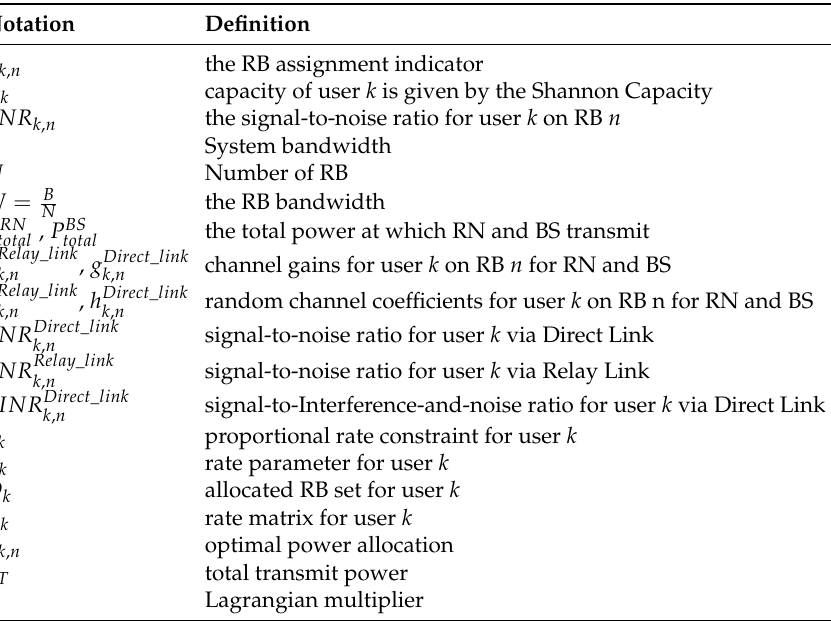
Table 1. List of